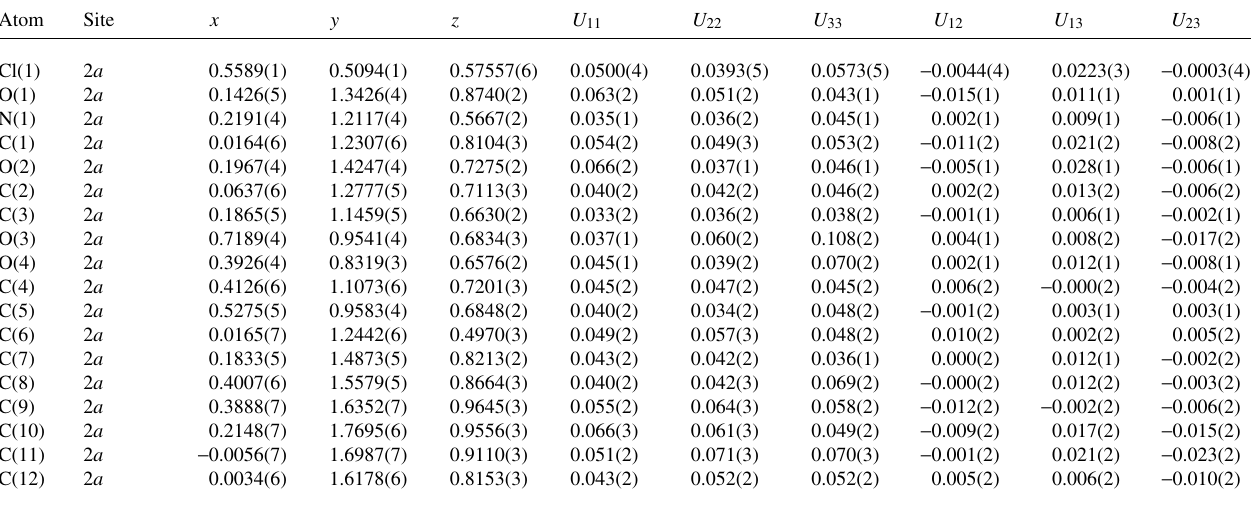
Table 3. Atomic coordinates and displacement parameters (in Å 2 )